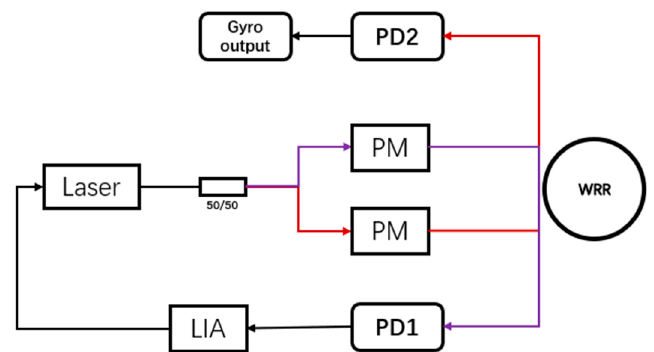
Figure 2. System structure of passive micro-optical gyros (MOGs). PM is a phase modulator. PD is a photo detector. LIA is a lock-in Amplifier.